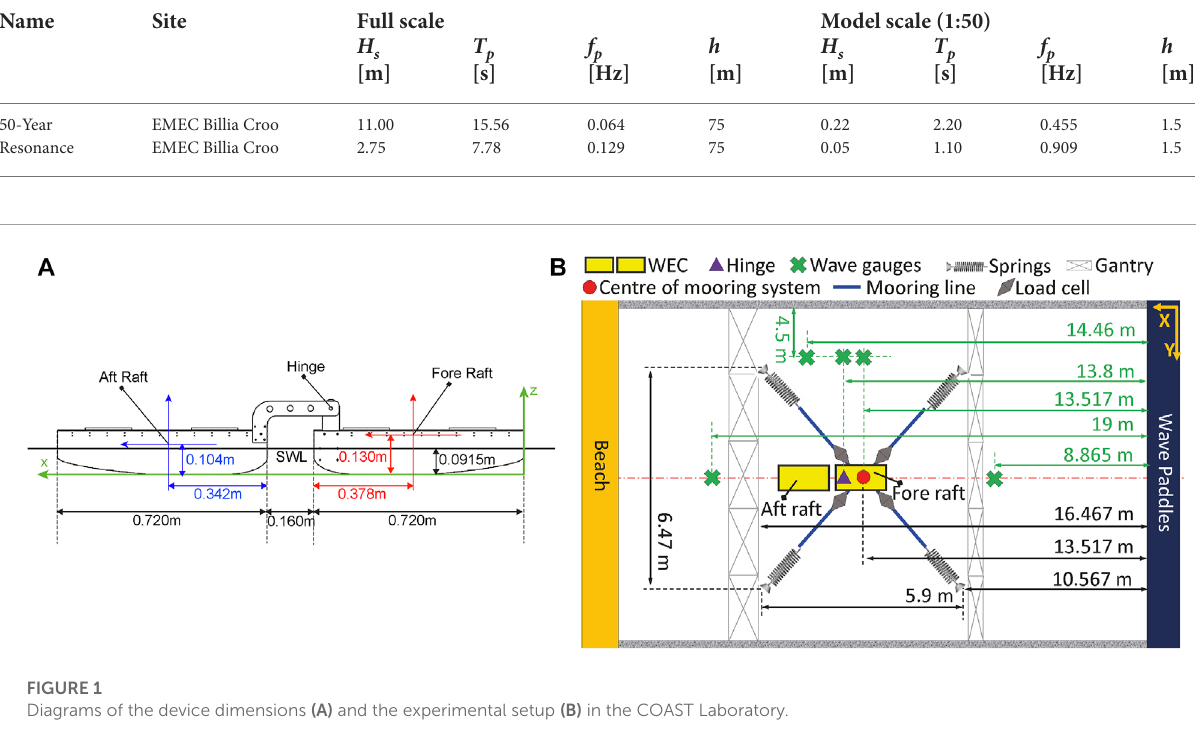
TABLE 2 Parametersofeachseastateconsideredinthisstudy.Eachistestedfor γ = 1and γ = 3 . 3.